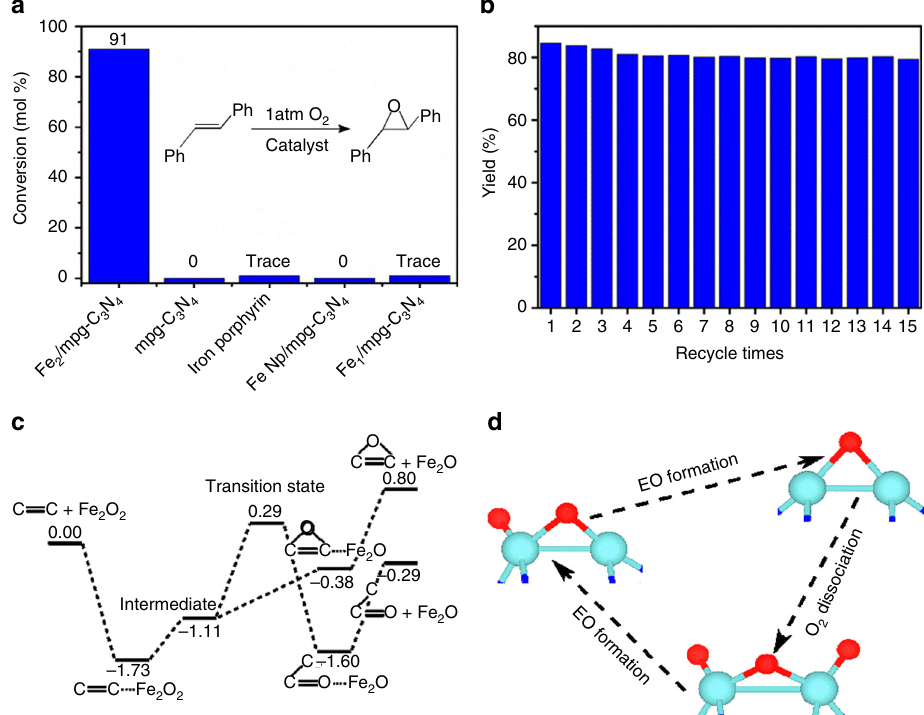
Fig. 3 Epoxidation of trans -stilbene. a Catalytic epoxidation of trans -stilbene using different catalysts. b Recycle of Fe 2 /mpg-C 3 N 4 for catalytic epoxidation of trans -stilbene. c Energy pro fi le (unit: eV) for the trans -stilbene epoxidation at the Fe 2 O 2 site. d Consumption and regeneration of the active one- coordinated oxygen